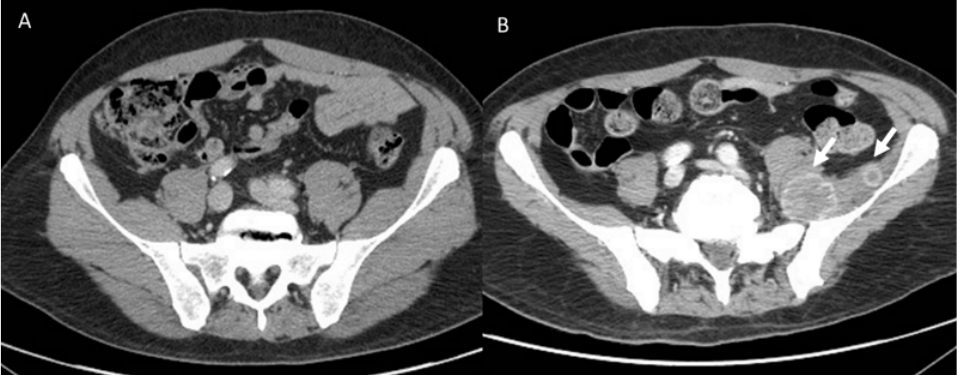
Figure 5. The same patient in Figure 4 ( A ). New lesions (arrows) in ileo-psoas muscle ( B ) due to iperprogression during immunotherapy.